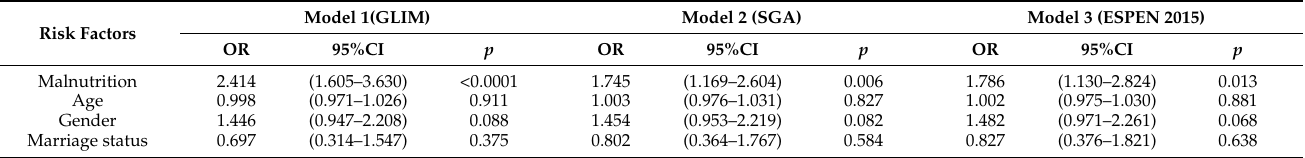
Table 3. Logistic regression analysis of the risk factors associated with the incidence of the total in-hospital complications in the elderly patients and the contributions made by the malnutrition diagnosis made with the GLIM, SGA, and ESPEN 2015 criteria,